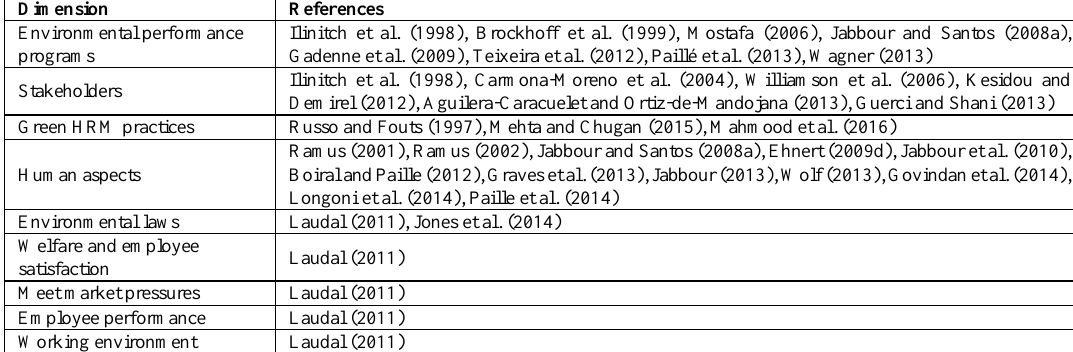
Table 7. Drivers for sustainable human resource management adoption